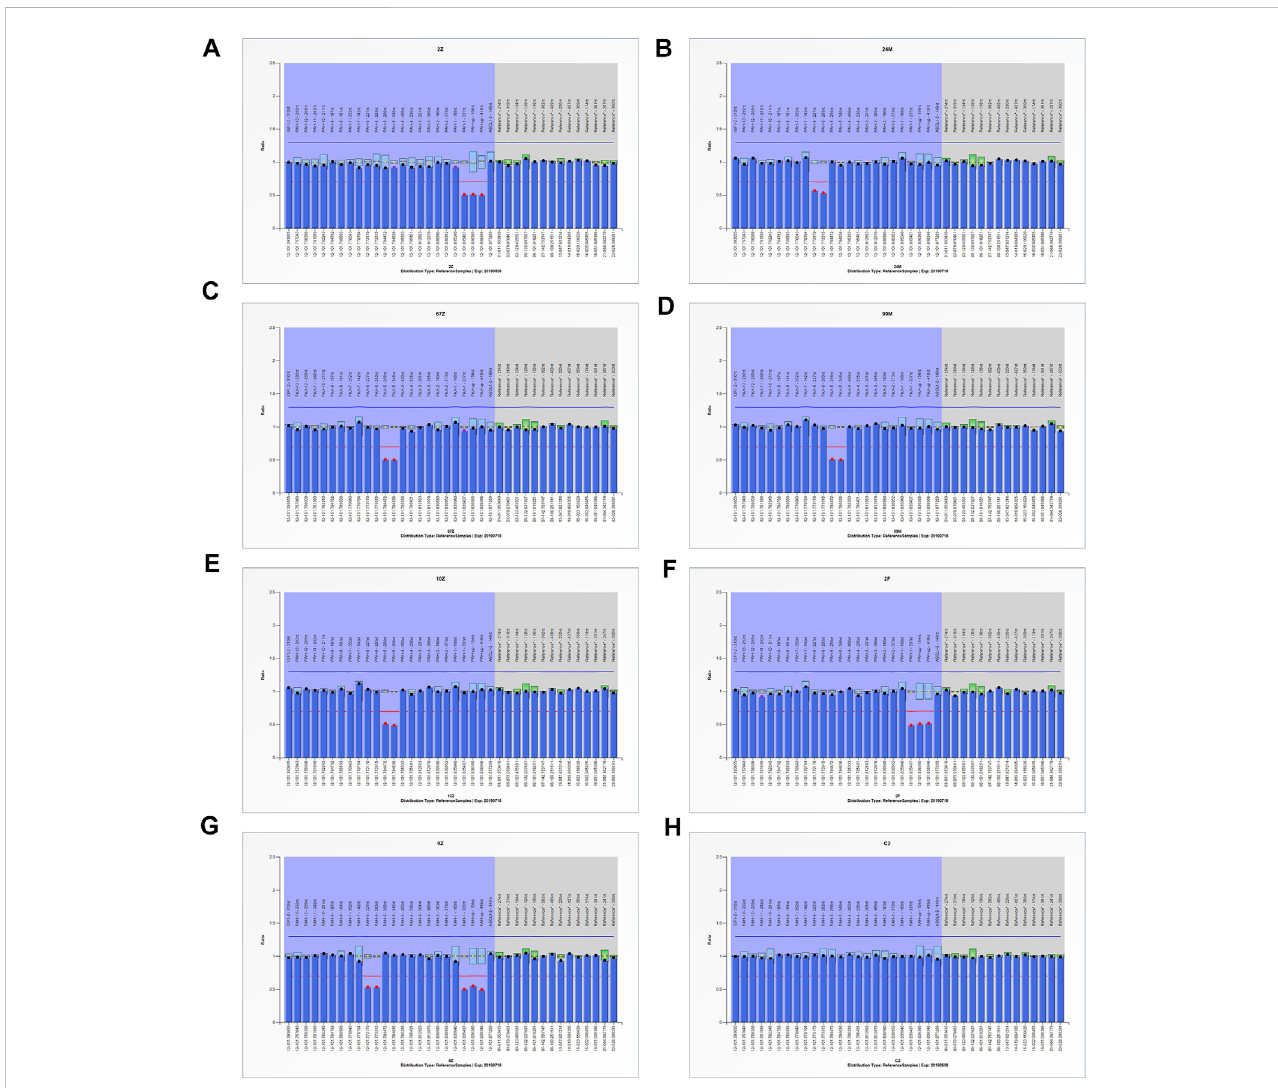
FIGURE 3 MLPA testing of seven PAHD patients. (A, F) The signal for the area spanning the 5 ′ -UTR and Exon1 was nearly half of the signal observed for the normal sample. (B) The signalfor the PAH Exon6 wasnearly halfofthesignalobserved forthenormal sample. (C,D,E) The signalfor the PAH Exon5 wasnearly halfof thesignal observed for the normal sample. (G) Both thesignal for the PAH Exon6 and the signal for thearea spanning the 5 ′ -UTR and Exon1 was nearly half of the signal observed for the normal sample. (H) normal sample.